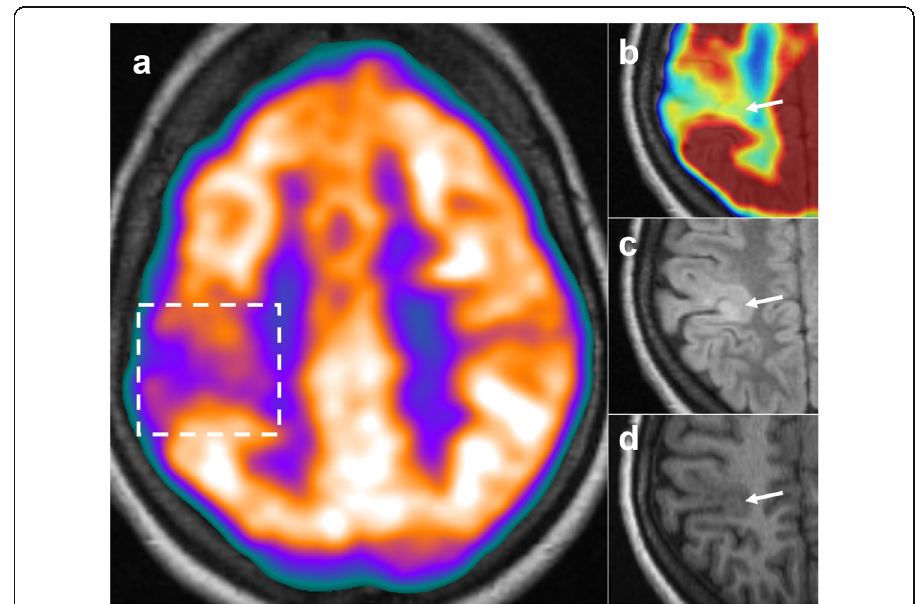
Fig. 1 Appearance of BOSD on PET and MRI. ( a ) Coregistered PET and MRI data is shown for one patient who exhibited BOSD MRI hallmarks, as well as focal hypometabolism on 18 F-FDG-PET. The area of focal hypometabolism is shown in the dashed box. The area of PET hypometabolism is shown in an inset area in ( b ) using a jet colour scheme. The FLAIR image ( c ) shows T2 hyperintensity of the BOSD, while this appears as a hypointensity on T1 ( d